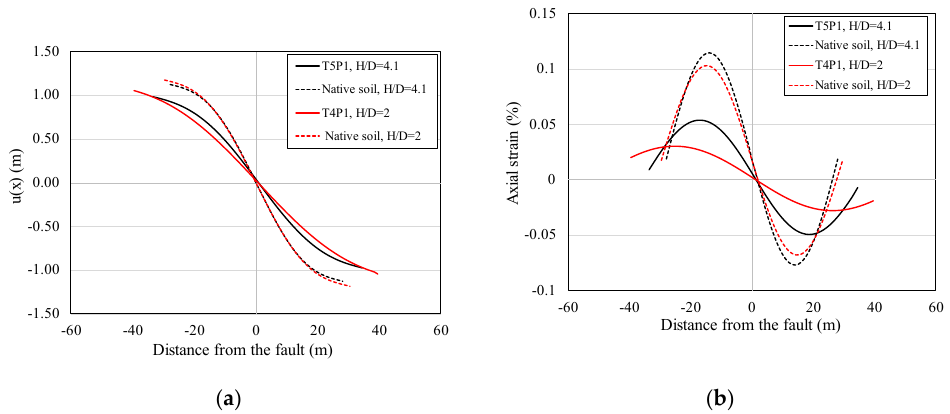
Figure 6. Comparison between the developed analytical model for the trenched pipeline and the analytical model for uniform seabed soil, T4P1 and T5P1 ( β = 0°): ( a ) deformed pipeline shape, ( b ) distribution of axial strains along the pipeline.